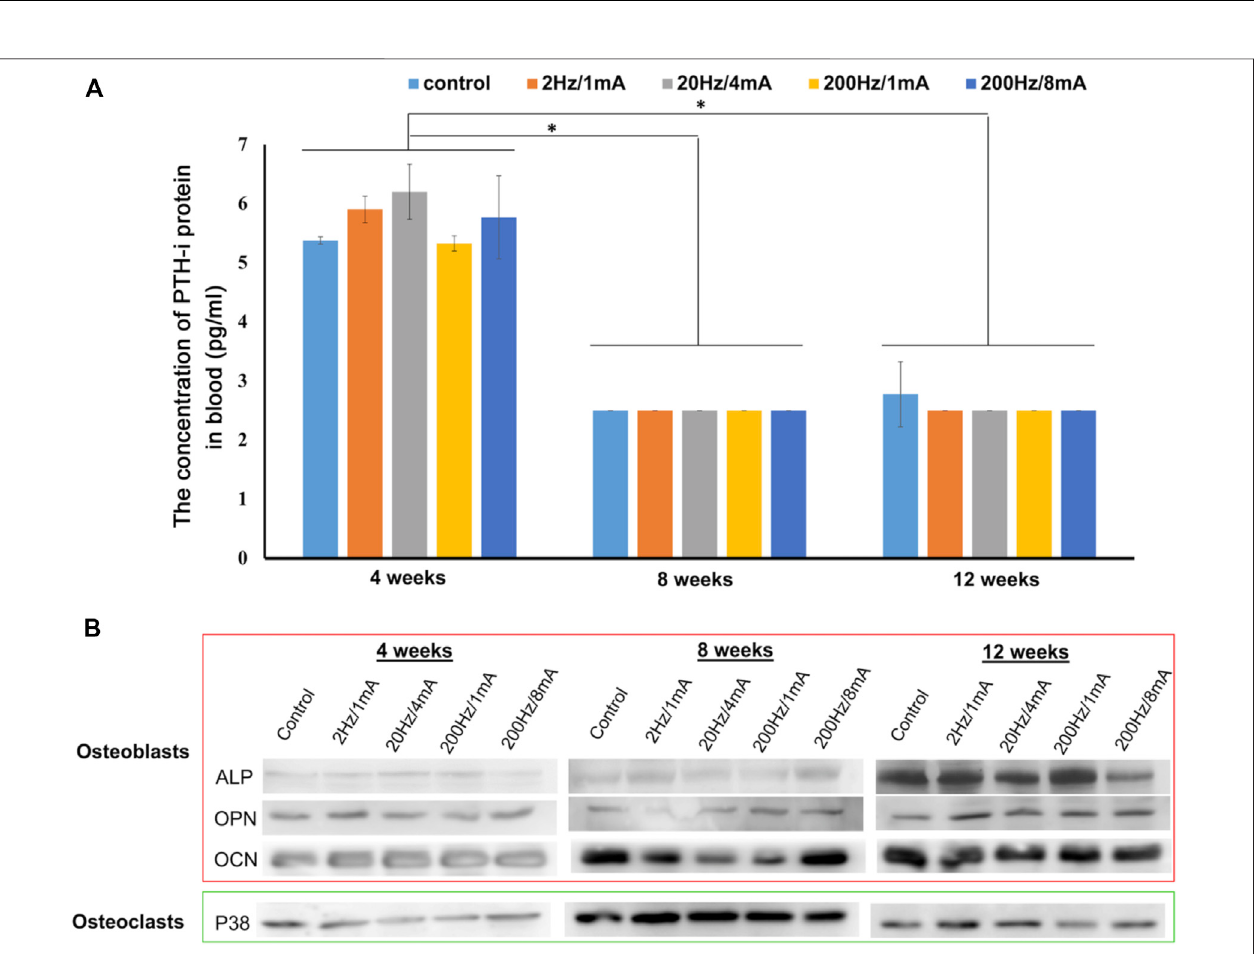
FIGURE 4 | (A) Hematological analysis of the PTH-i expression of the bone-defected rats was treated with electroacupuncture for 4, 8, and 12 weeks. (B) The osteoclast activation protein (p38) and osteoblast differentiation/mineralization proteins (ALP, OPN, and OCN) in the bone-defected tissues after treating with electroacupuncture stimulation were analyzed by using the Western blot assay. The control group indicated the rats with the implanted GGT scaffold and without ES treatment. (The number of rats per group = 4, * p < 0.05.)